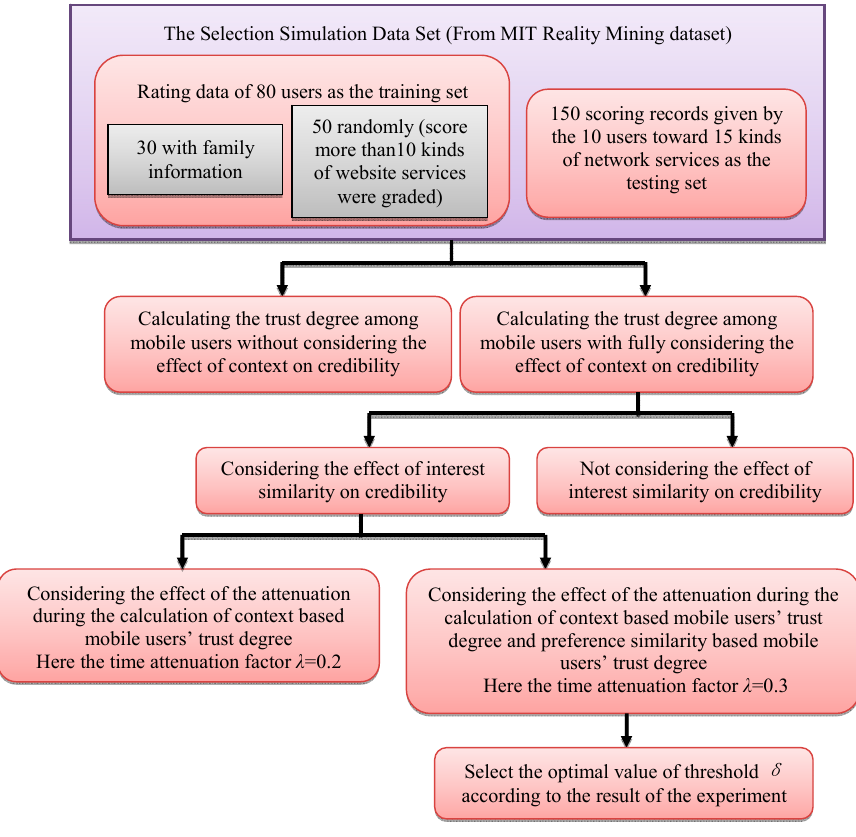
Figure 4. The flow diagram of the simulation steps.